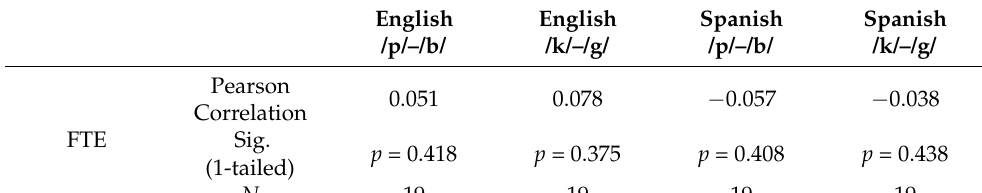
Table 3. Results for the correlation tests between FTE and category boundaries for the English learners of Spanish.